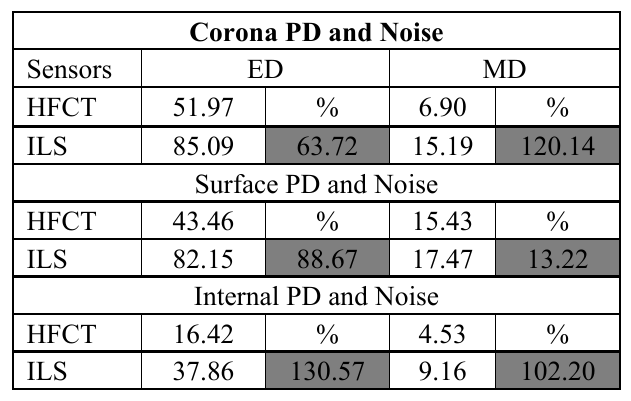
Table 5. MD and ED between clusters obtained with the two sensors for the intervals. PRL [20, 40] MHz and PRH [40, 60] MHz.